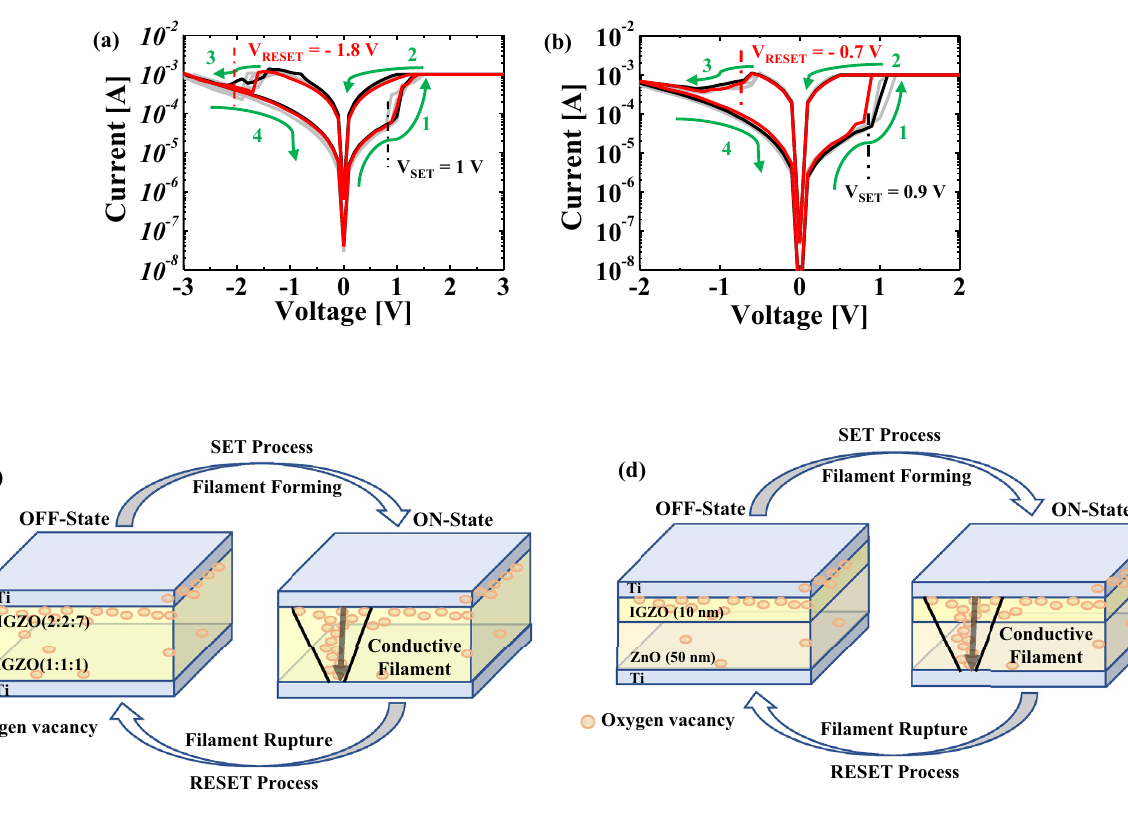
Figure 2. I-V typical bipolar switching behavior of ( a ) a single IGZO and ( b ) bi-layer IGZO/ZnO memristors, and the switching behavior of ( c ) a single IGZO and ( d ) bi-layer IGZO/ZnO